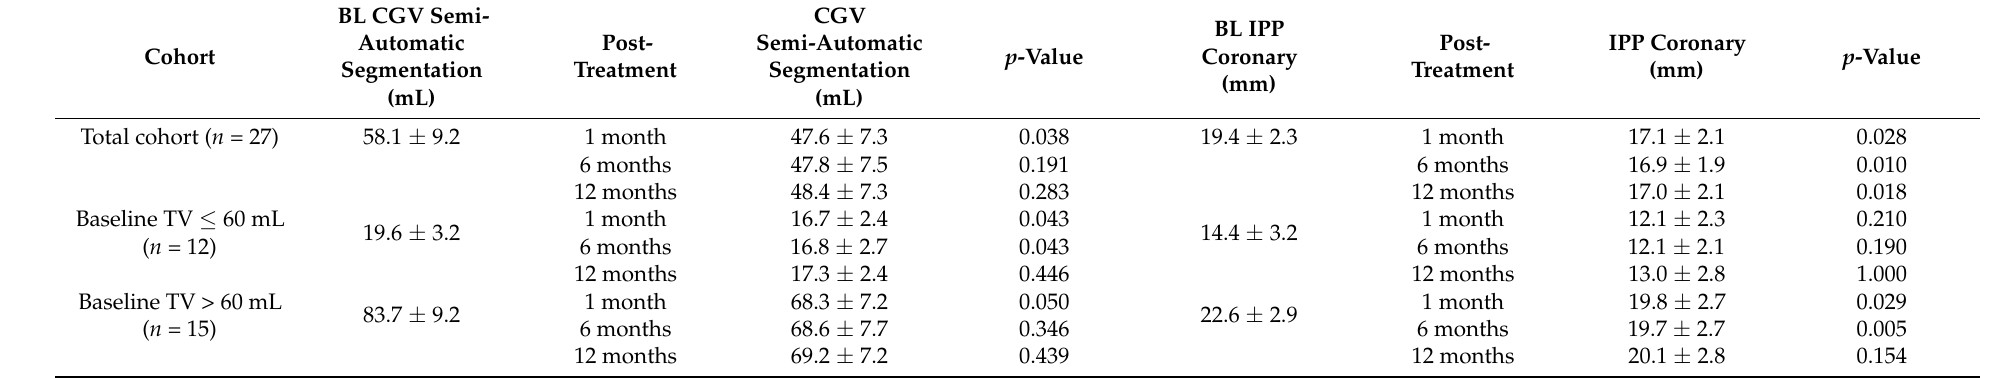
Table 4. Pre- and post-treatment CGV and IPP. Values presented as means ± SD. p values include Bonferroni multiple testing